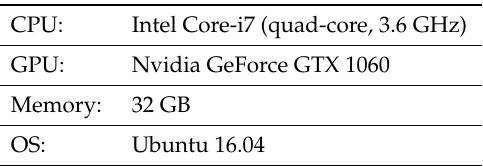
Table 1. Test system specifications.